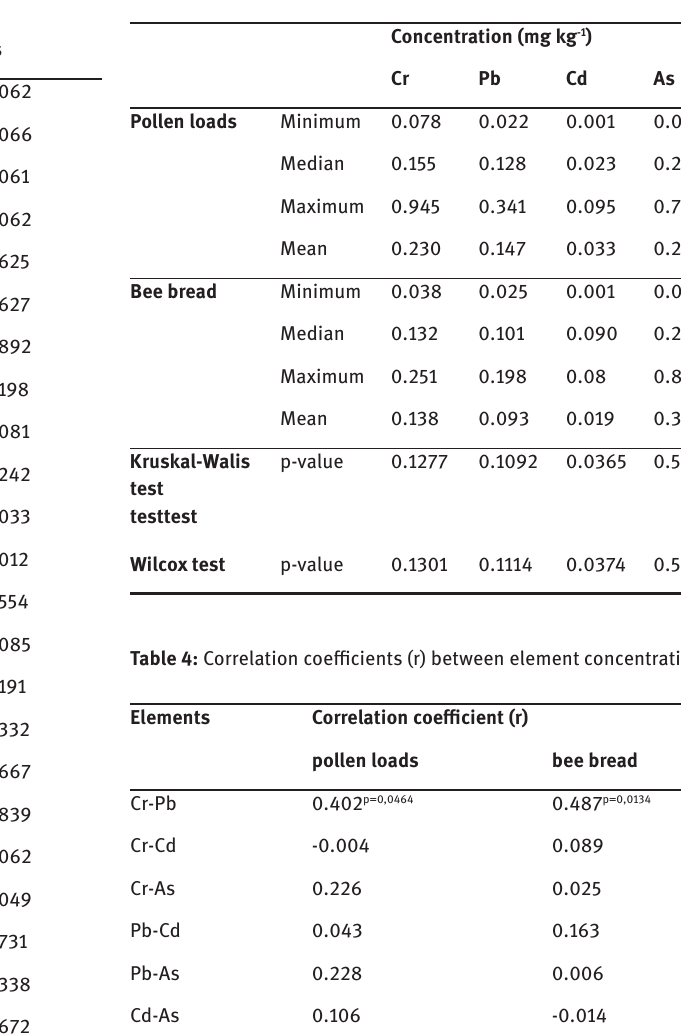
Table 3: Comparison of concentrations in pollen loads and bee bread from Lower Silesia.